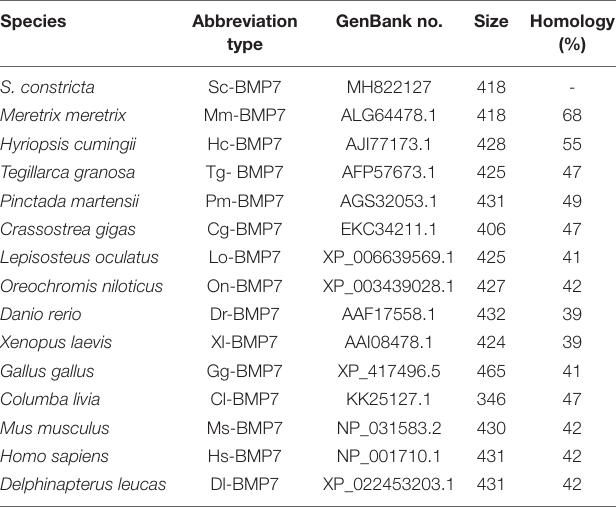
TABLE 2 | Species and GenBank accession numbers of BMP7s sequence used for multiple alignment and phylogenetic analysis. Species